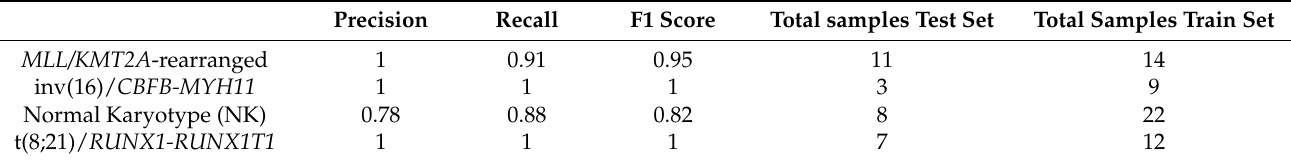
Table 2. Precision, recall, F1 scores per subtype, as well as overall accuracy of the classifier for the four subtypes with >5 patients in the group. High precision scores indicate the low number of false positives (FP) while high recall scores the low number of false negatives